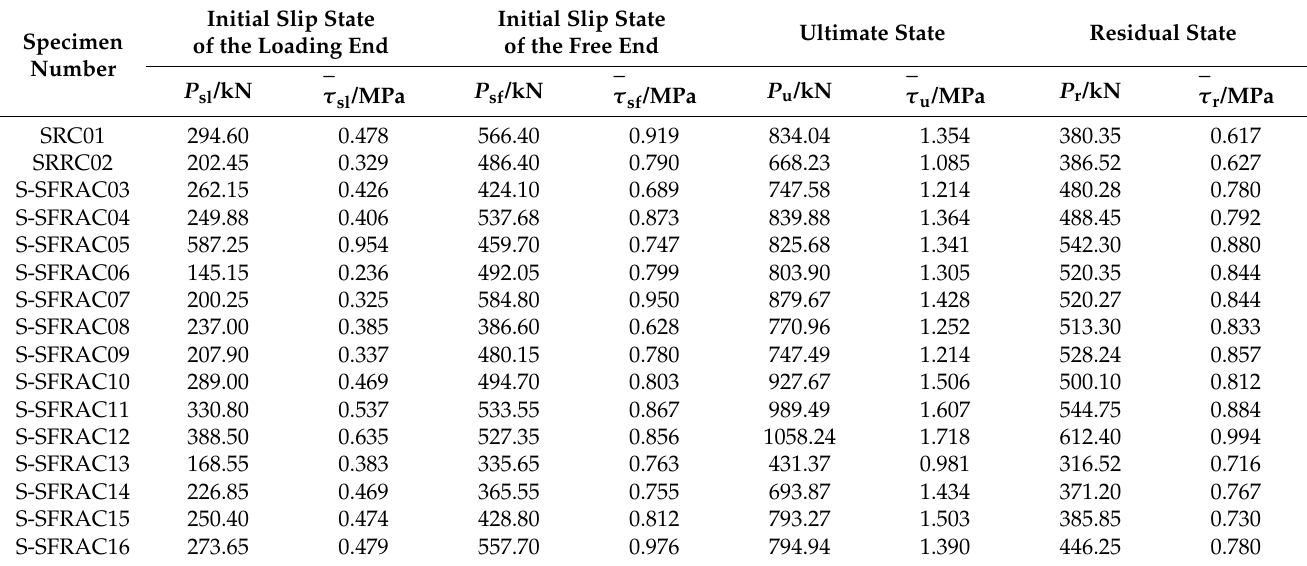
Table 6. Characteristic loads and bonding